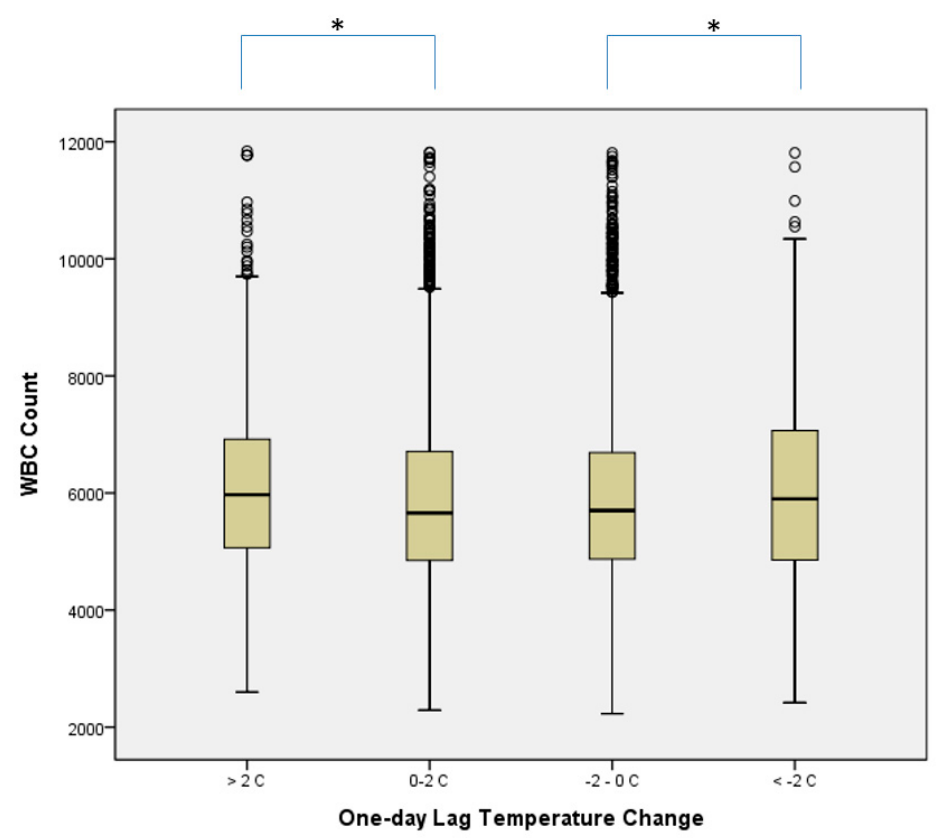
Figure 2. Box and Whisker plots of WBC counts by the difference values of one-day lag temperature change; * p < 0.05 by Scheffe test.